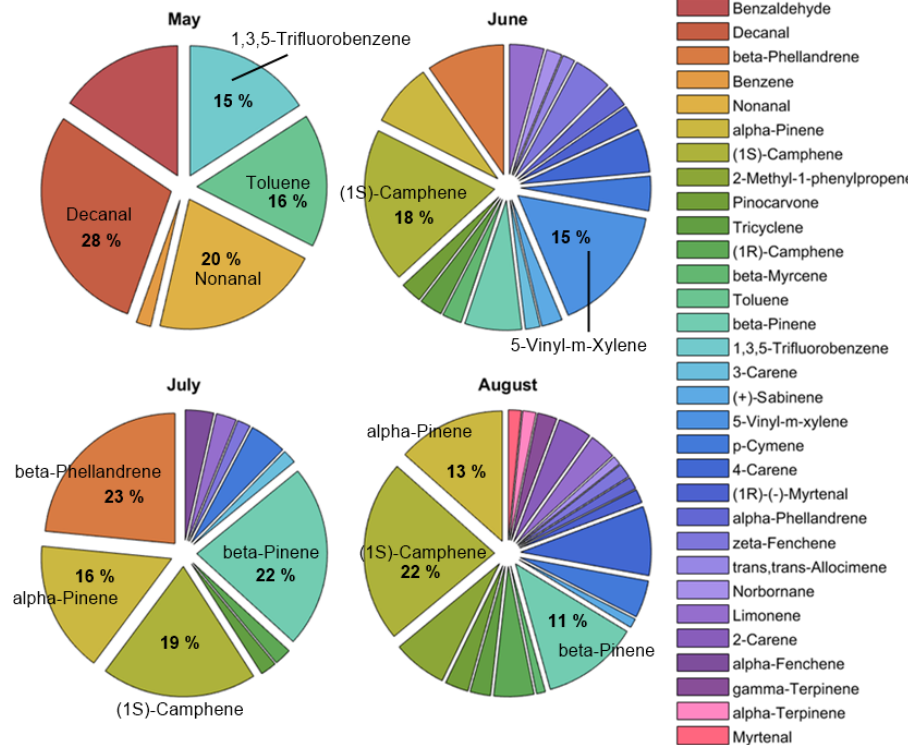
Figure A1. The daily average blend from the Norway spruce S3S3 and percentage contribution in mass throughout the summer (May, June, July and August), showing only compounds with a mass contribution of at least 1%.